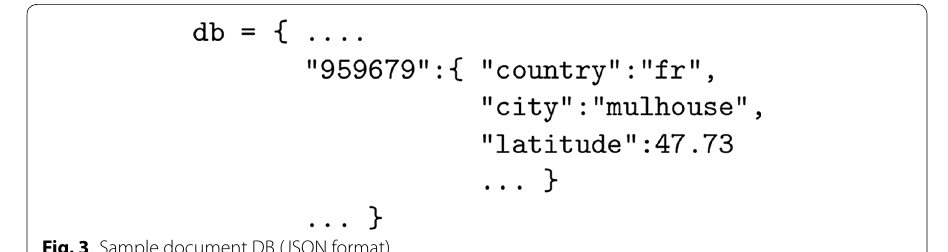
Fig. 3 Sample document DB (JSON